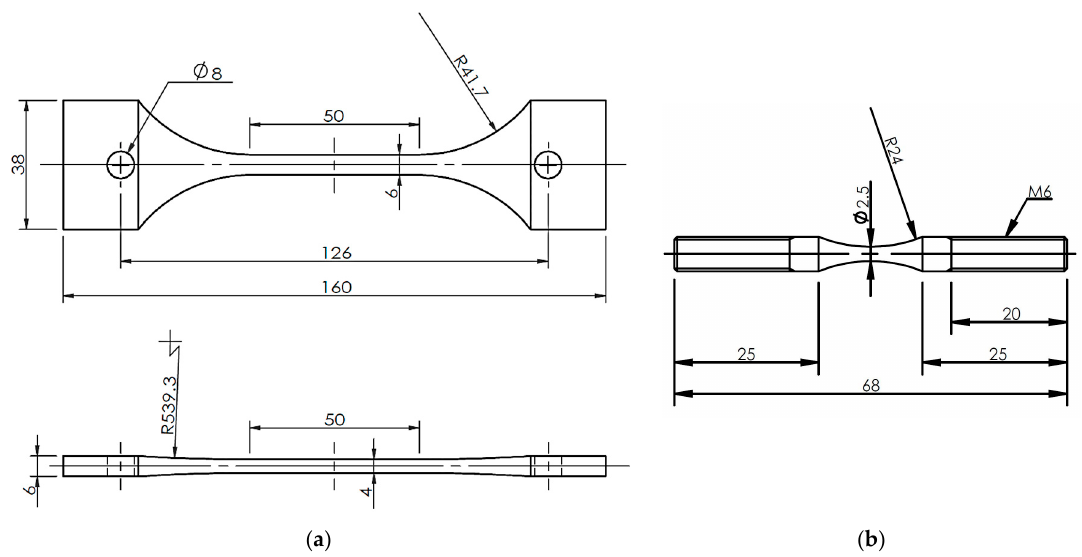
Figure 4. Geometries and dimensions of the plate and round bar specimens. ( a ) Plate specimen; ( b ) Small round bar specimen.